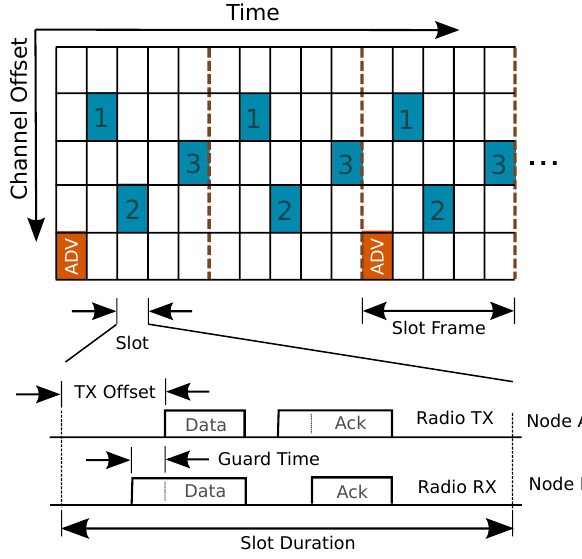
Figure 3. Time synchronized channel hopping in WSNs: a node synchronizes to its time parent by listening to advertisement (ADV) packets. Packets are sent a predetermined time into a slot, permitting for efficient resynchronization. Once synchronized, a node is assigned a slot and channel offset, and only communicates with neighbors according to this schedule.